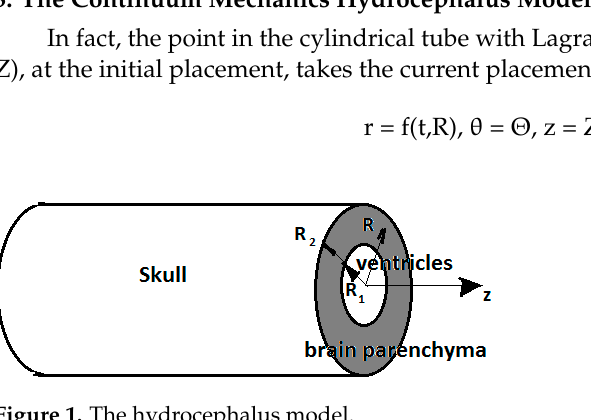
Figure 1. The hydrocephalus